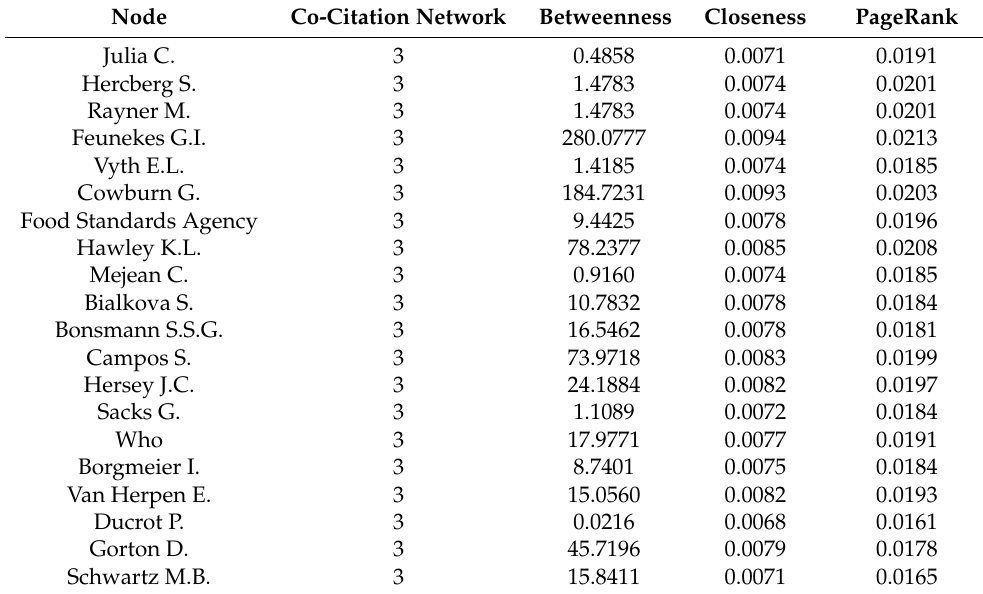
Table 9. The relative strength of the nodes within co-citation network 3. Node Co-Citation Network Betweenness Closeness PageRank Julia C. 3 0.4858 0.0071 0.0191 Hercberg S. 3 1.4783 0.0074